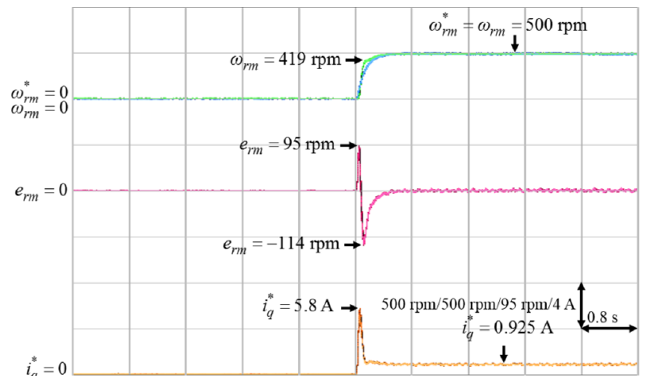
Figure 8. Experimental results of ACSM speed controller from standstill to 500 rpm in Case 4.